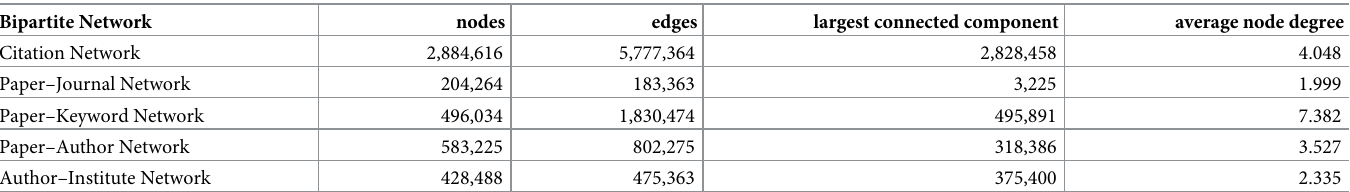
Table 7. Summary of the created heterogeneous